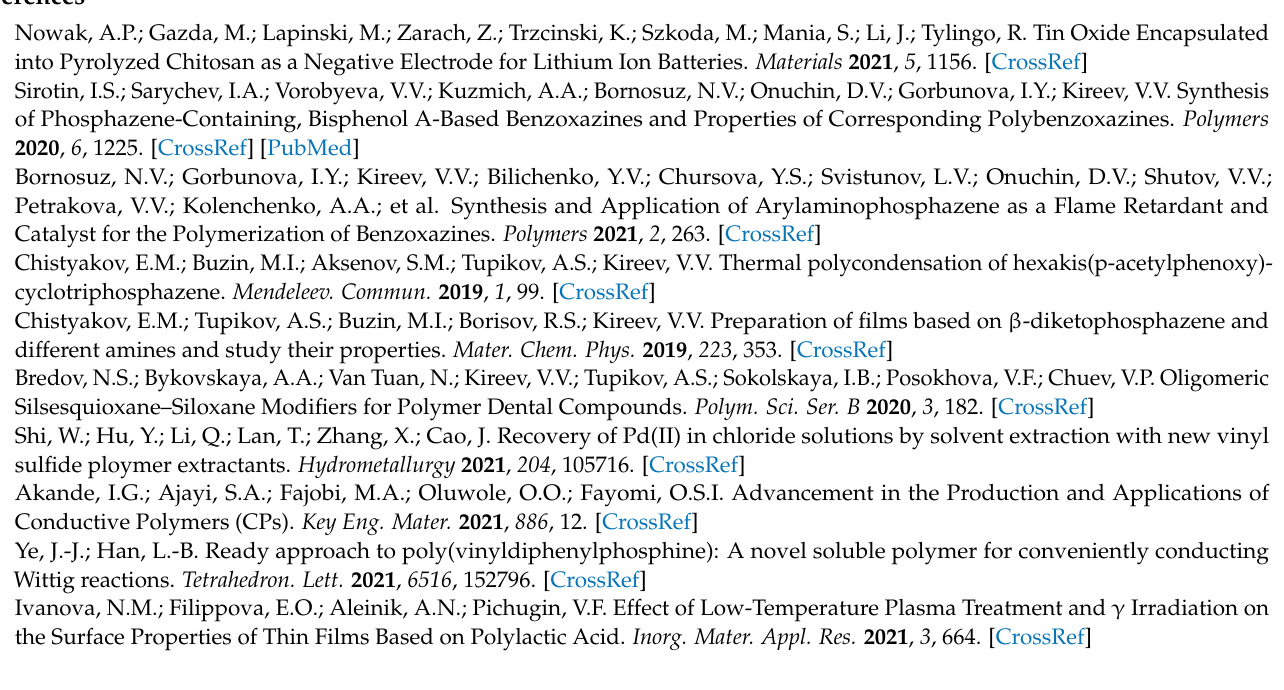
Figure S4: 13 C NMR spectrum poly(2-methyl-2-oxazoline), Figure S5: GPC curve of the synthesized poly(2-methyl-2-oxazoline), Figure S6: TGA curve poly(2-methyl-2-oxazoline), Table S1: Molecular weight characteristics of the synthesized